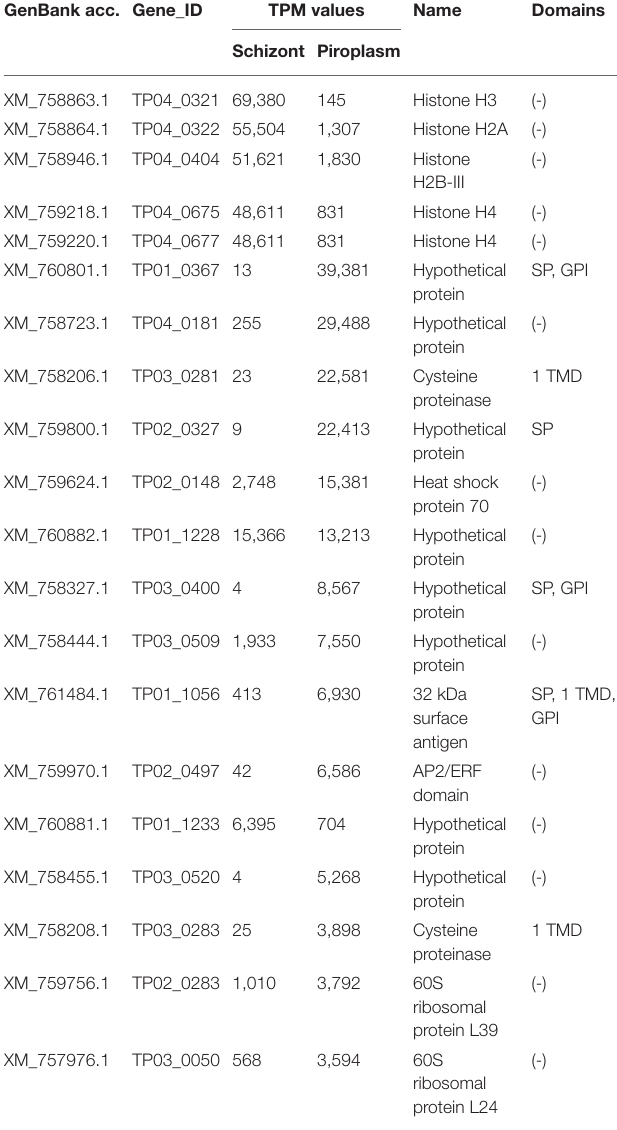
TABLE 3 | Top 20 highest expressed